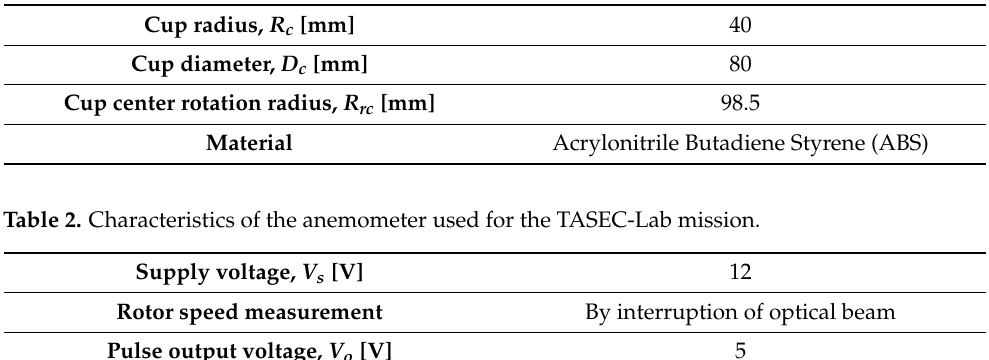
Table 1. Characteristics of the rotor used for the TASEC ‐ Lab mission.